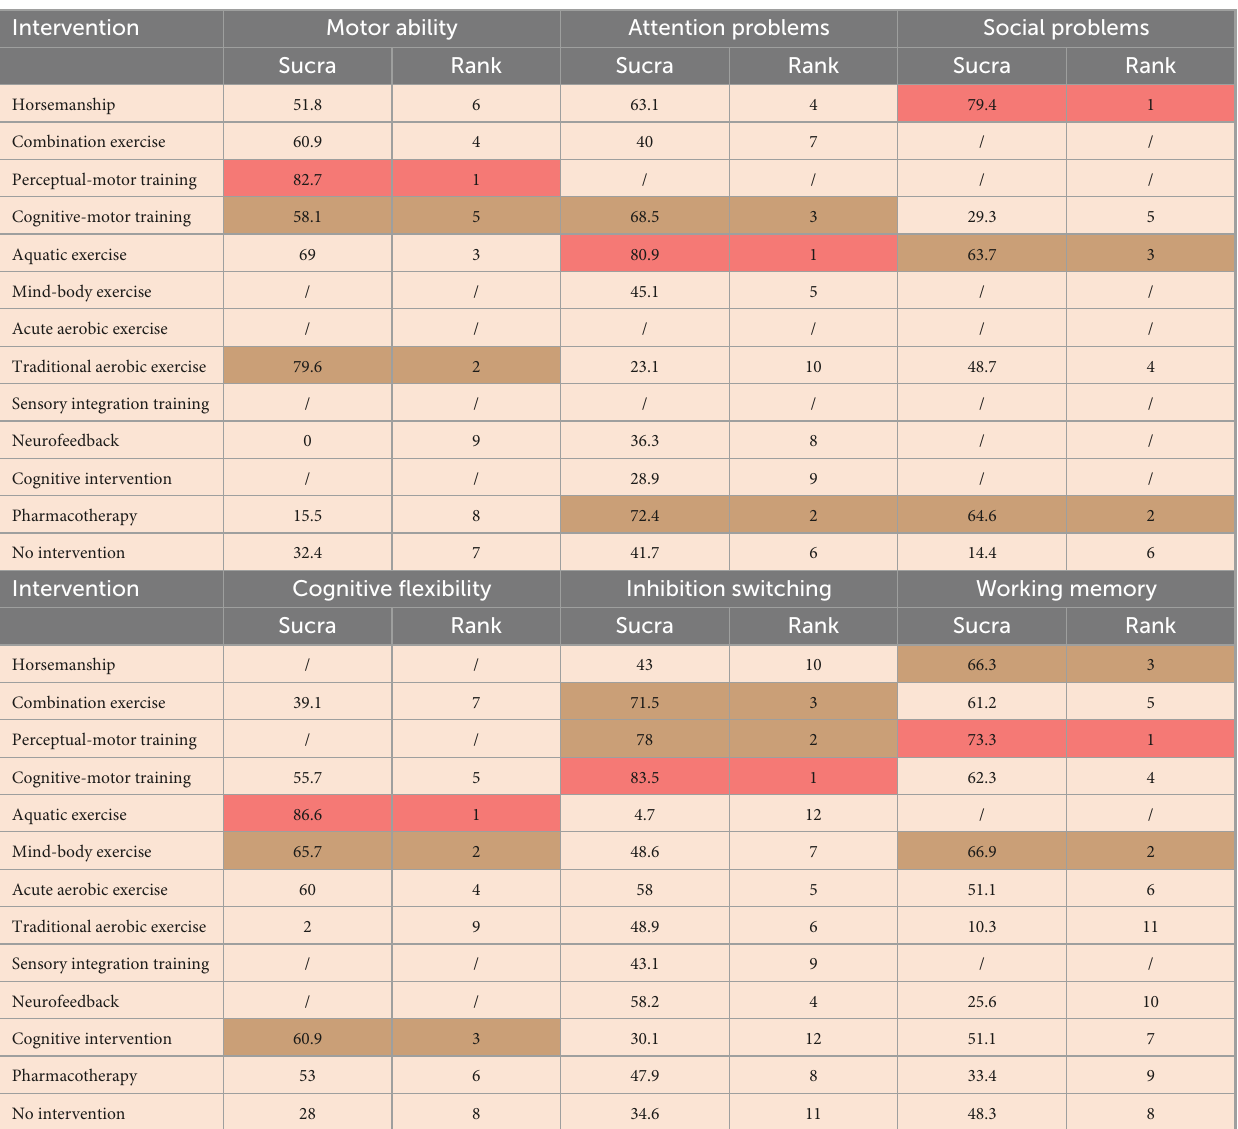
TABLE 8 Ranking of SUCRA probabilities for each outcome indicator. Intervention Motor ability Attention problems Social